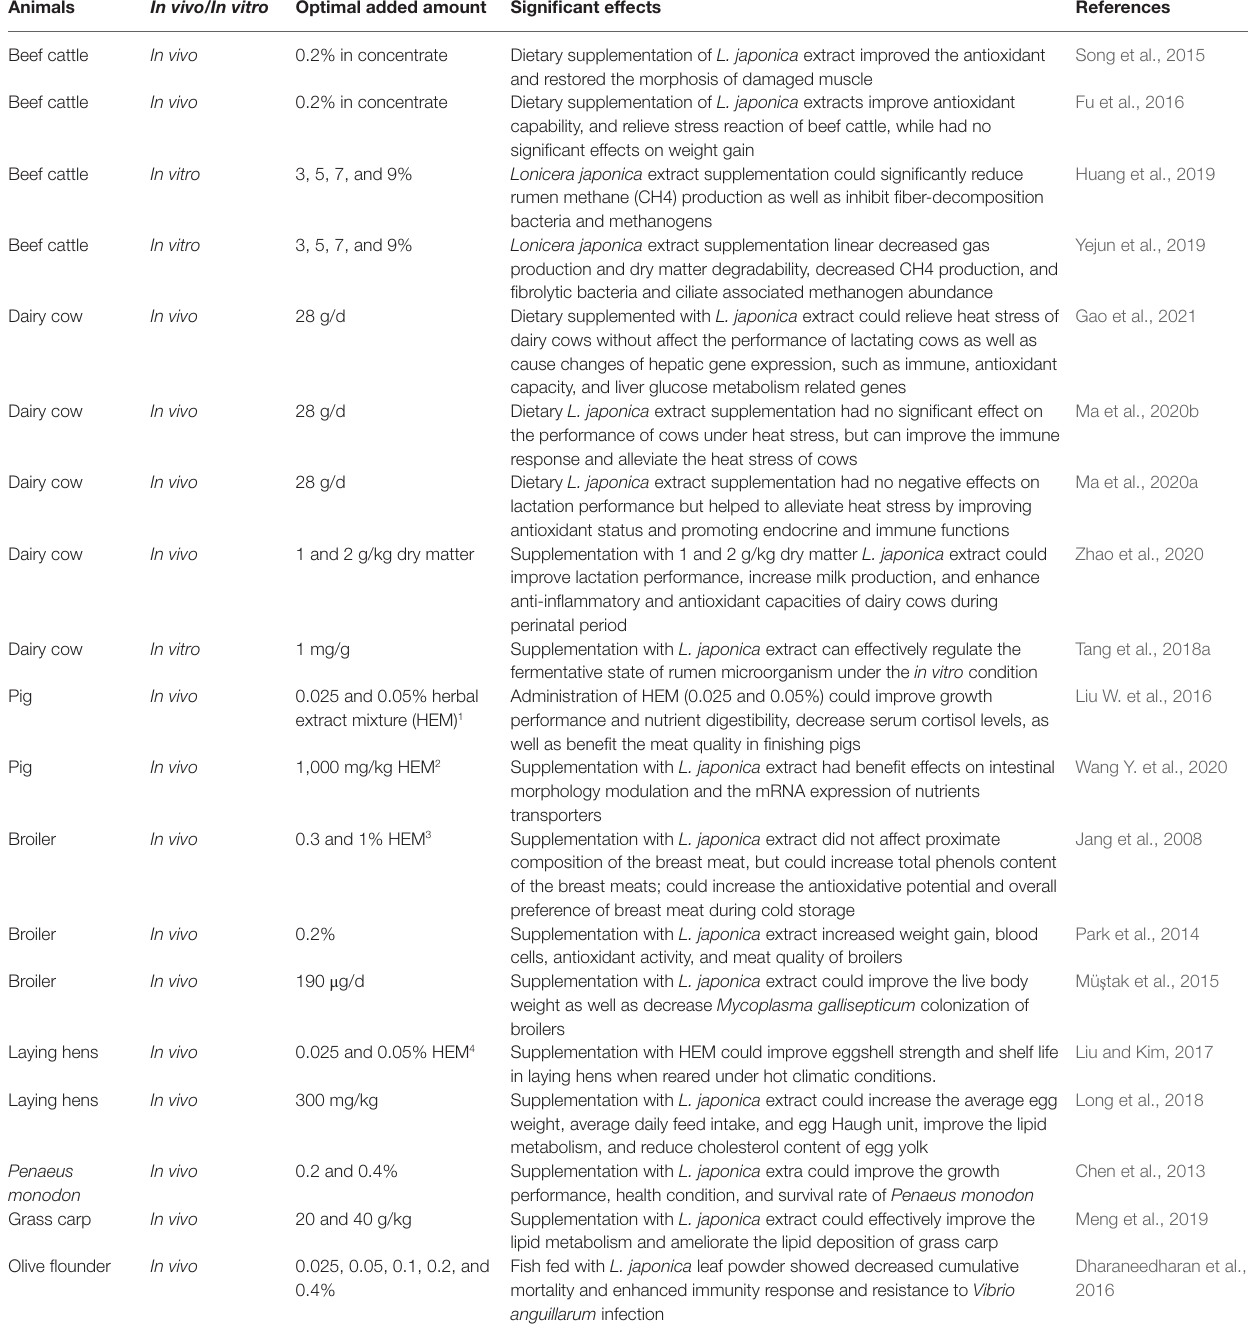
TABLE 2 | Application of L. japonica in animal production. Animals In vivo / In